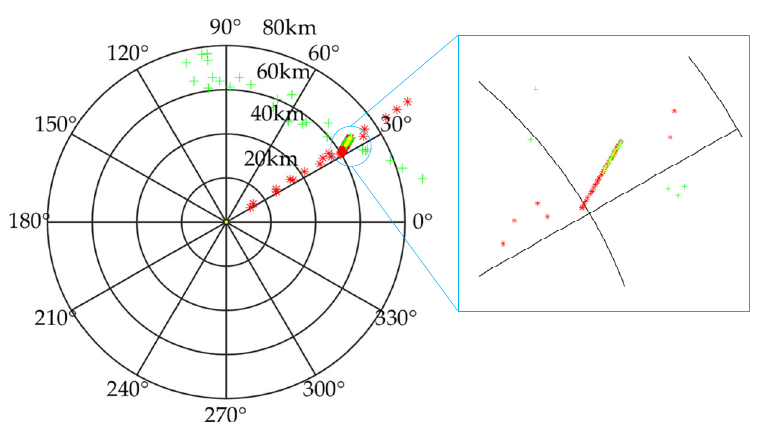
Figure 9. True target fusion results with a jamming range delay of 0 km including overall rendering and partly enlarged view, where green line (plus) denotes the track detected by radar 1, red line (asterisked) is detected by radar 3, and yellow line (dotted) is the target track that satisfies the fusion criterion.